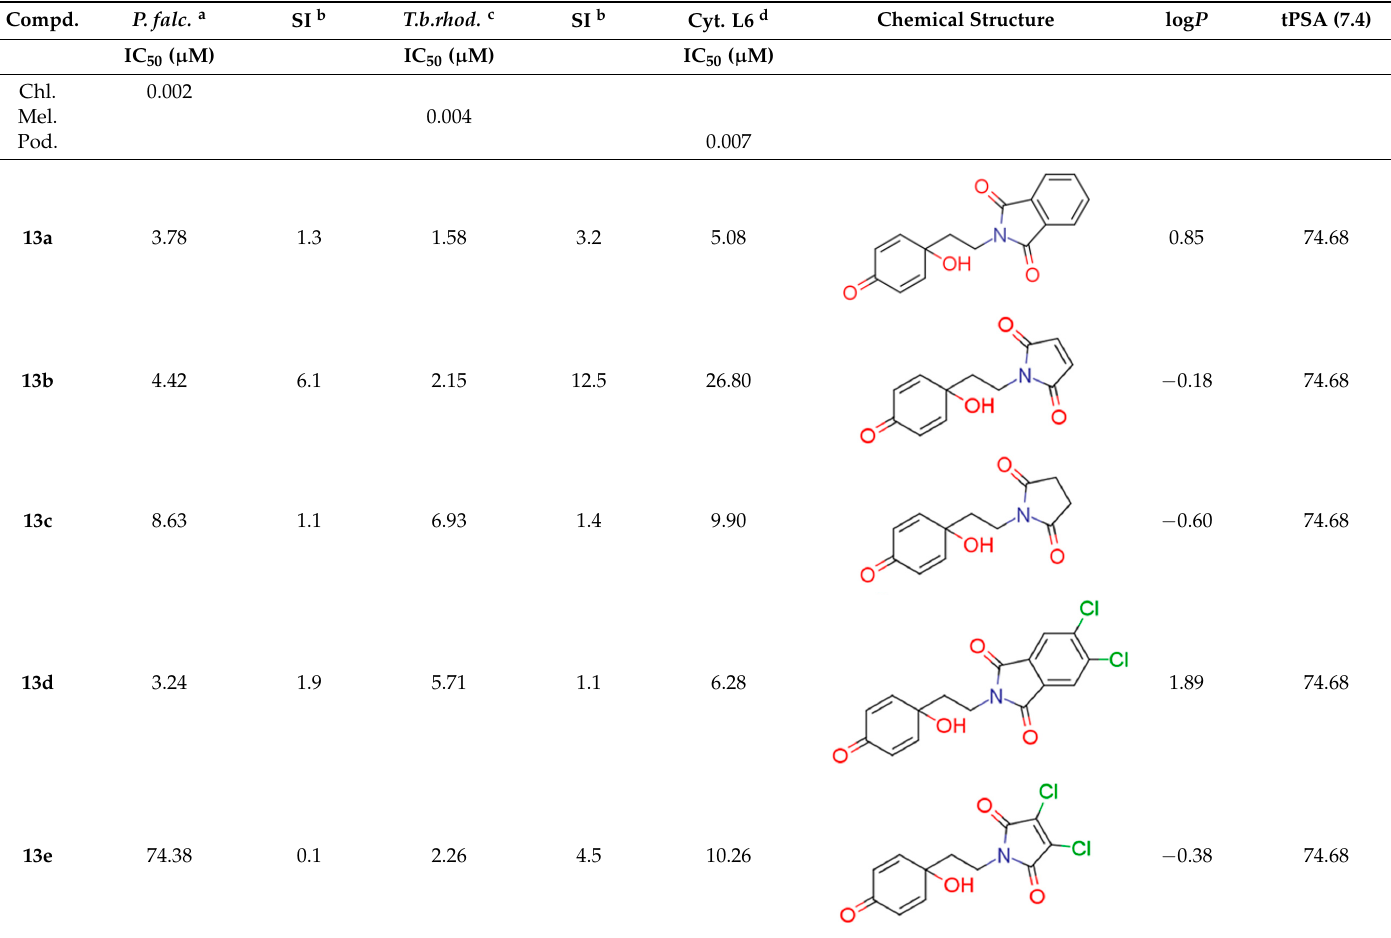
Table 1. In vitro antiparasitic activity, host toxicity, and key physicochemical properties of tested compounds. Compd. Chl.